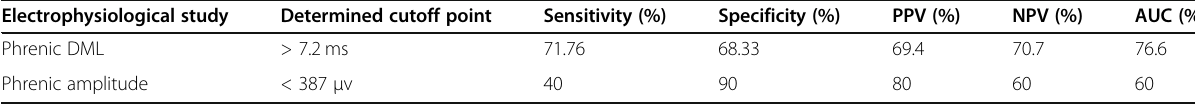
Table 2 The determined cutoff points for different electrophysiological studies Electrophysiological study Determined cutoff point